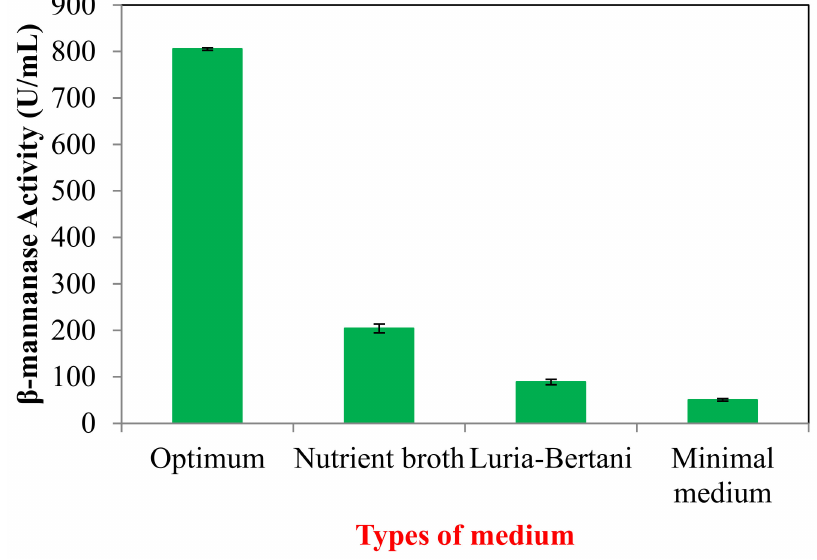
Figure 3. Verification experiment for β -mannanase by B. subtilis ATCC 11774. The results are expressed as the means of triplicate readings with an estimated error of ±